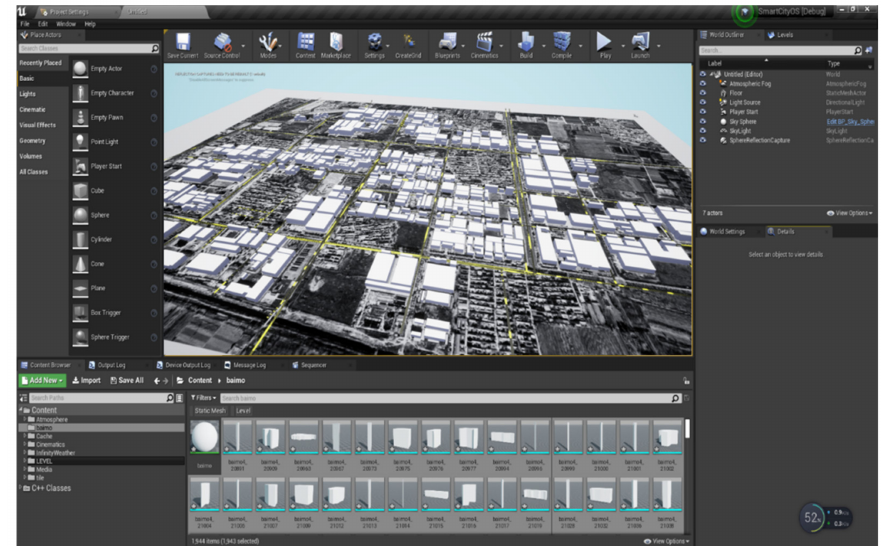
Figure 6. Importing the building model, DSM, and DOM data into the UE4 editor.